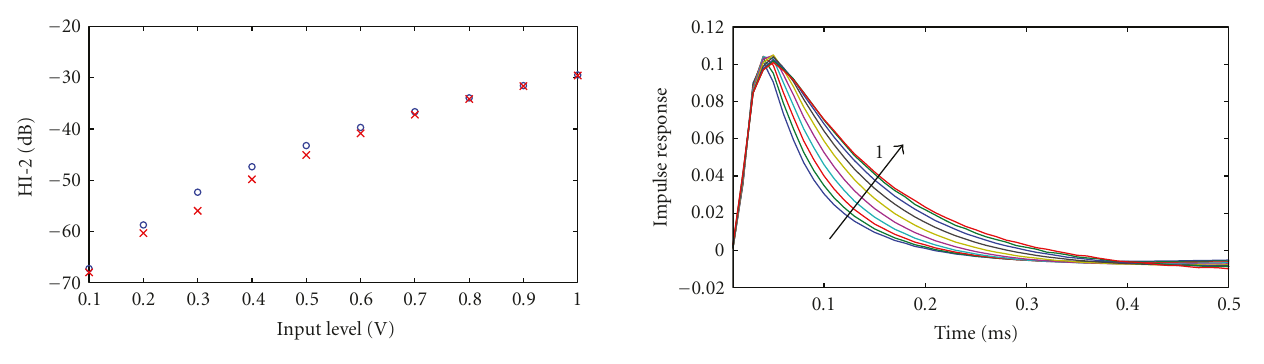
Figure 12: Impulse responses a 1, l ( t ) of the first branch of the nonlinear model ( N = 7) depicted for di ff erent input levels (pedal